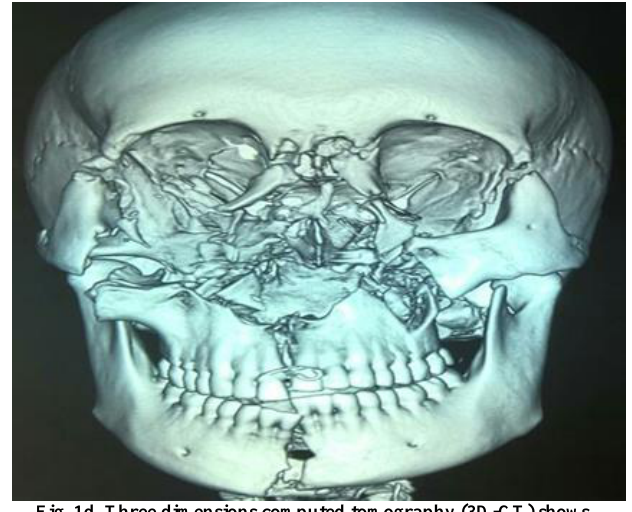
Fig. 1d. Three dimensions computed tomography (3D-CT) shows mandibular symphyseal fracture in a pan facial trauma patient.